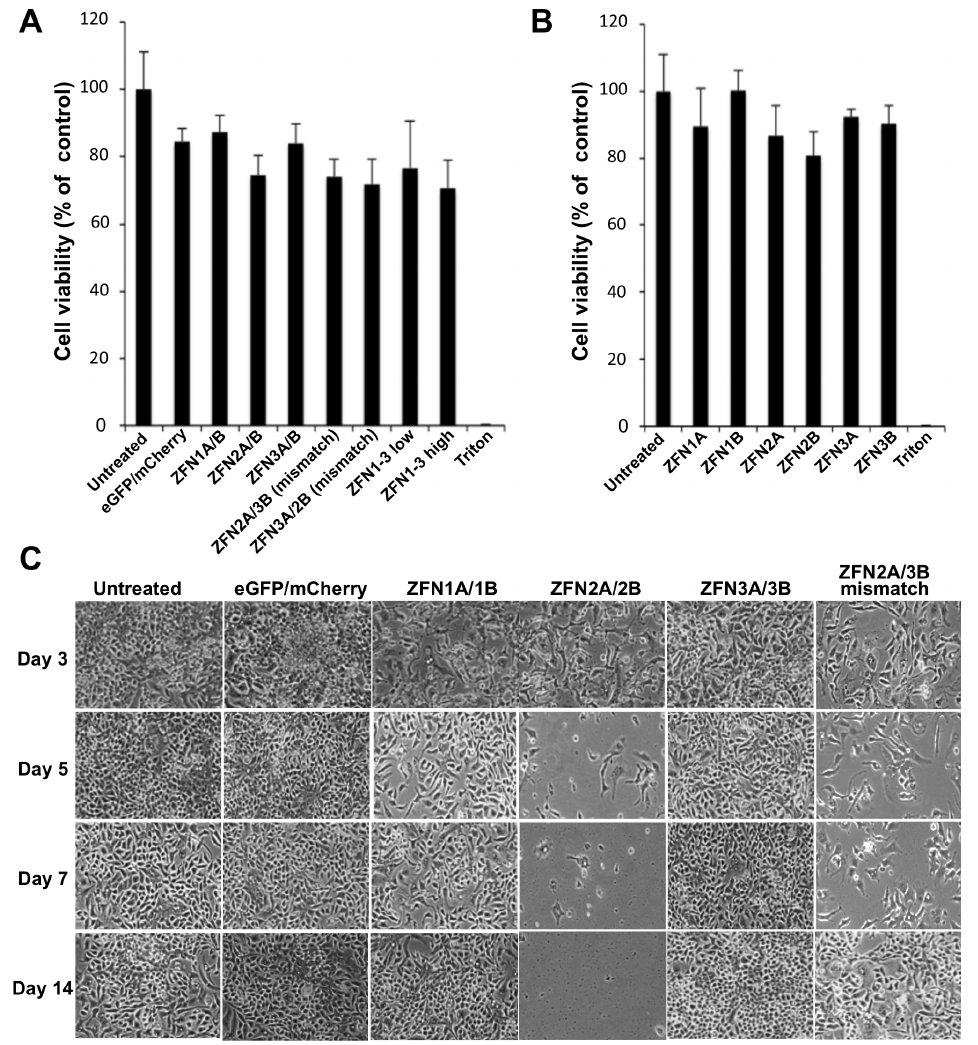
Figure 4. scAAV-ZFN induced cytotoxicity. ( a ) HepAD38 cells were transduced with scAAV2 vectors expressing GFP and mCherry reporter genes, ZFN pairs 1, 2 or 3, or mismatched ZFN pairs at a total MOI of 10000 genomes/cell, or all 3 ZFN pairs at a total MOI of 10000 (low) and 30000 (high) genomes/cell. At 48 hours post transduction, cell viability was measured by MTT assay and reported as percent of control. ( b ) HepAD38 cells transduced with scAAV2 vectors expressing individual ZFN half sites at a MOI of 5000 genomes/cell were also analyzed. ( c ) Untreated cells and cells treated with scAAV2 vectors expressing reporter genes, ZFN pairs 1, 2 or 3 or a mismatch ZFN pair were monitored for cell viability at 3, 5, 7 and 14 days post transduction. eGFP – enhanced green fluorescent protein; ZFN – zinc finger